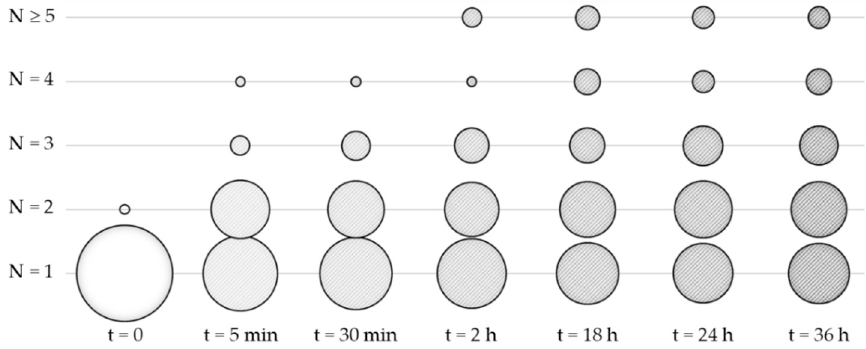
Figure 6. Evolution of the distribution of the number of silica patches with time. The surface of the disks is proportional to the fraction of the monopods assembled in PS particles of similar patch number. Self-assembly experimental conditions: [monopods] = 4C = 2.9 × 10 15 part./L at 25 °C in ethanol/THF volume ratio 20/80. The data for t = 0 and t = 24 h correspond to the Entry #1.3 of Table 1 and Entry #2.7 of Table 2, respectively.